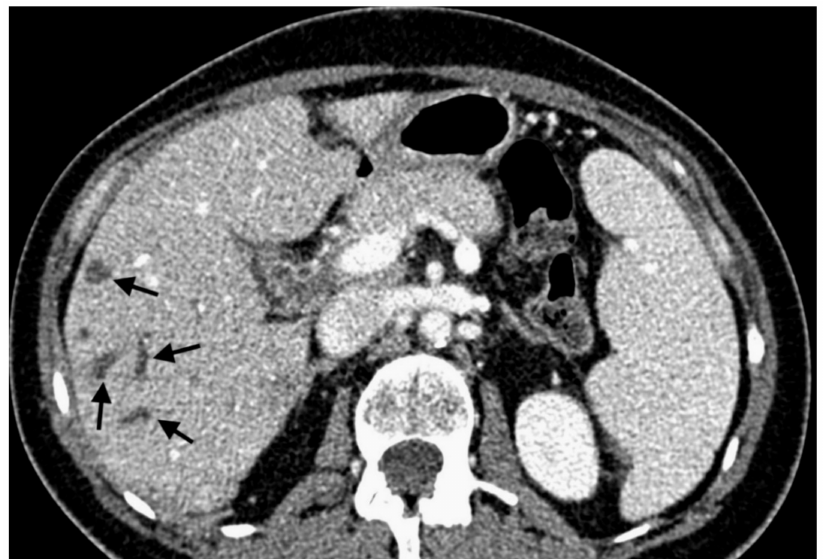
Figure 1. Contrast-enhanced multidetector computed tomography scan showing bile duct dilatation (black arrows) after transarterial chemoembolization with drug-eluting microspheres preloaded with